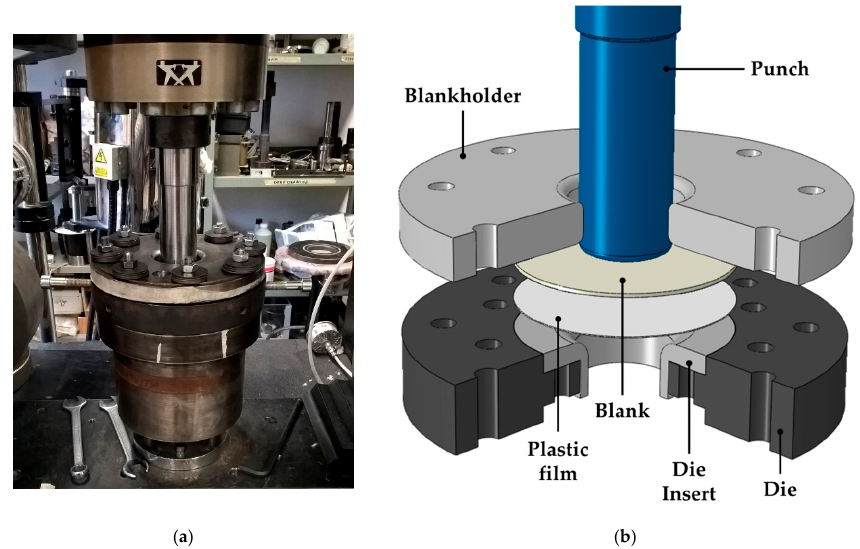
Figure 6. Local laser treatment: ( a ) 102 mm diameter blank preparation, ( b ) experimental setup.